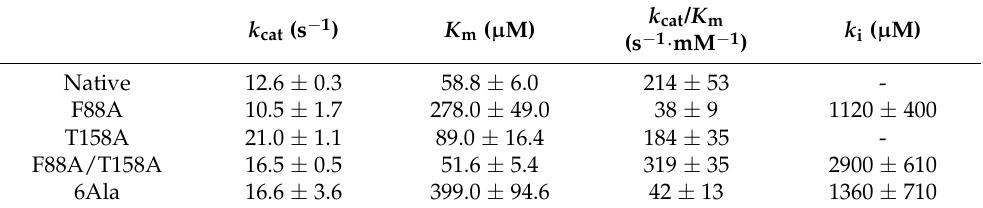
Table 2. Kinetic constants for oleic acid oxygenation by native r Cvi UPO and variants. k cat (s − 1 )